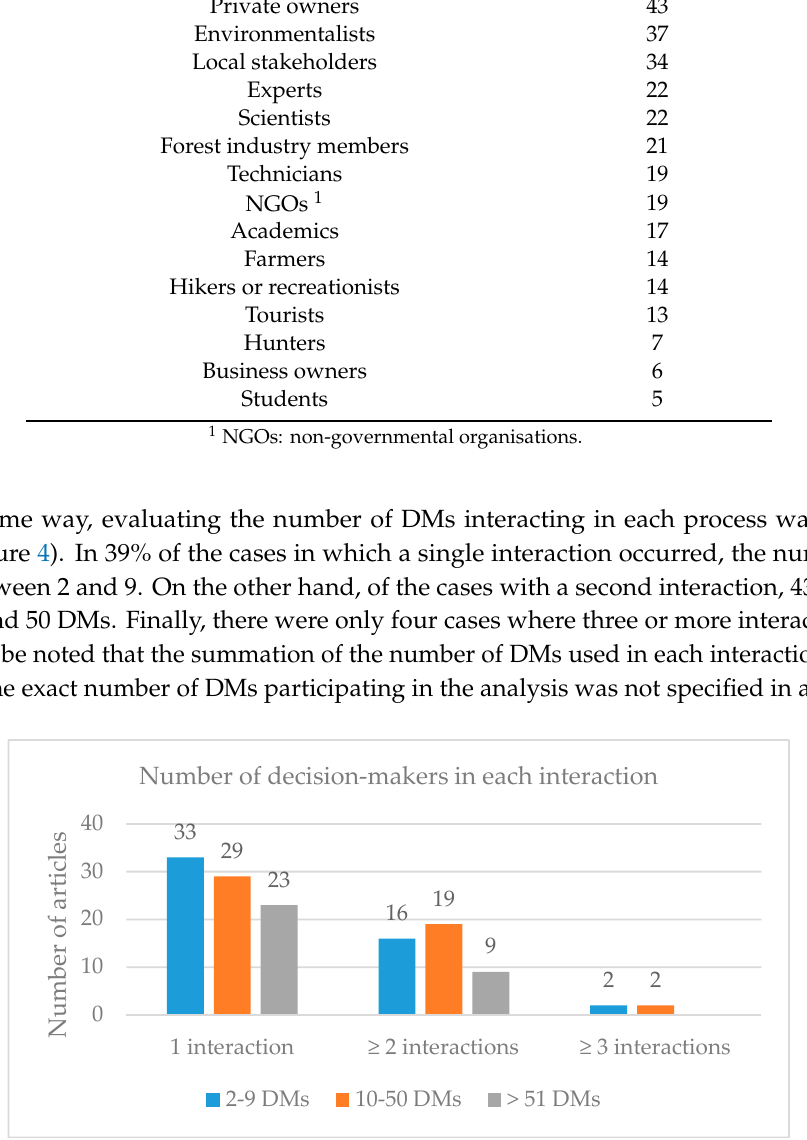
Figure 4. Number of decision-makers (DMs) in each interaction.